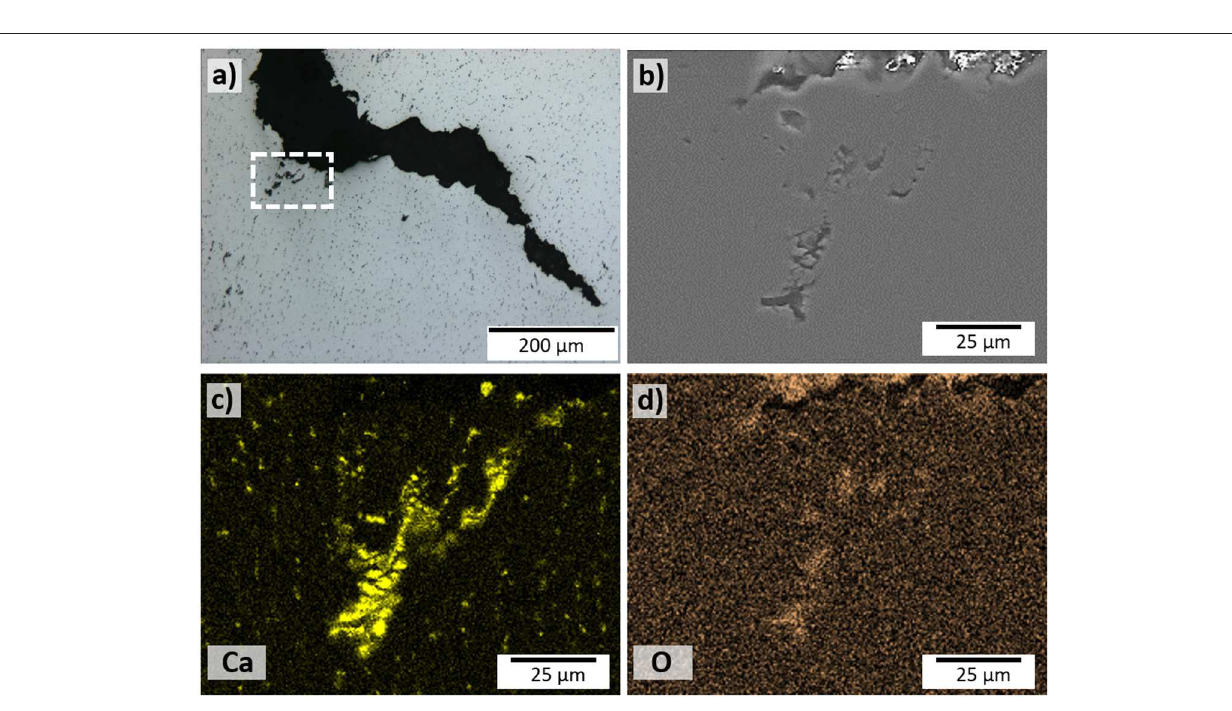
identified twinning mode mainly corresponds to {1 0 − 1 2} extension twins covering an area fraction of around 7.4%.